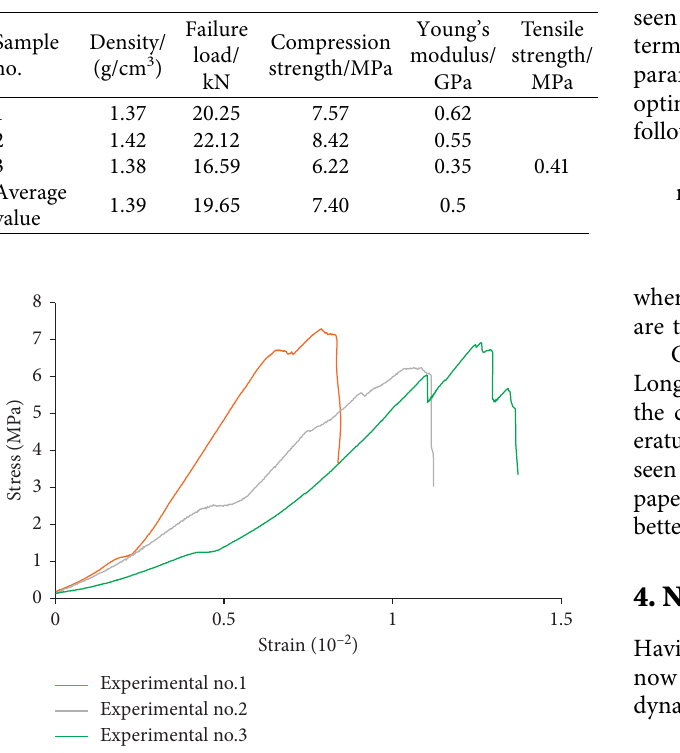
Figure 1: Full stress-strain curves of the coal